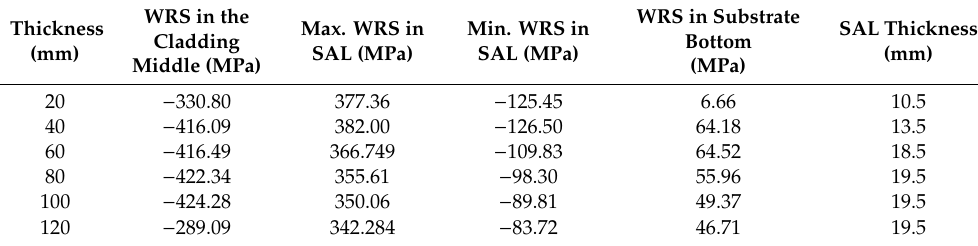
Table 2. Results for different substrate thicknesses. Note: SAL, stress-affected layer.